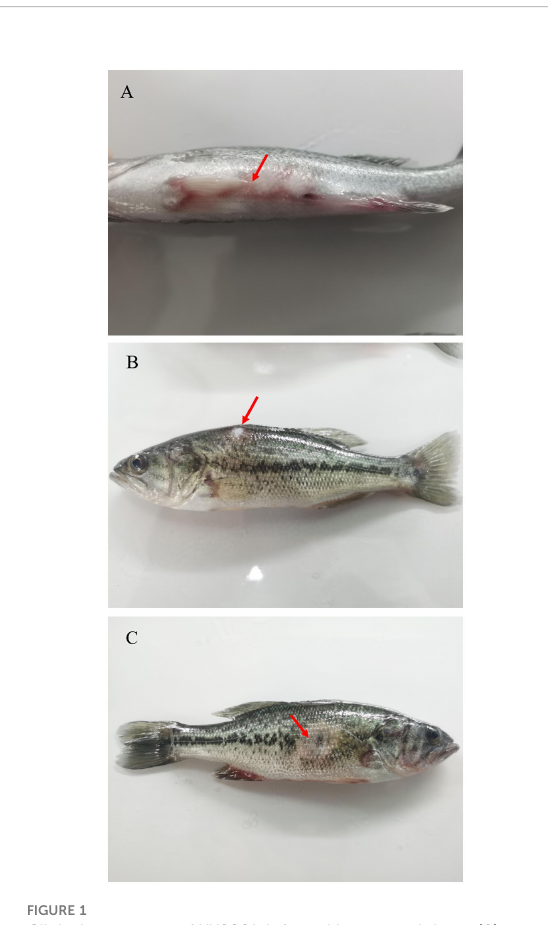
FIGURE 1 Clinical symptoms of XX2021-infected largemouth bass. (A) Hemorrhage in the abdomen (red arrow); (B) Ulceration on the back (red arrow); (C) Ulceration on the abdomen (red arrow).